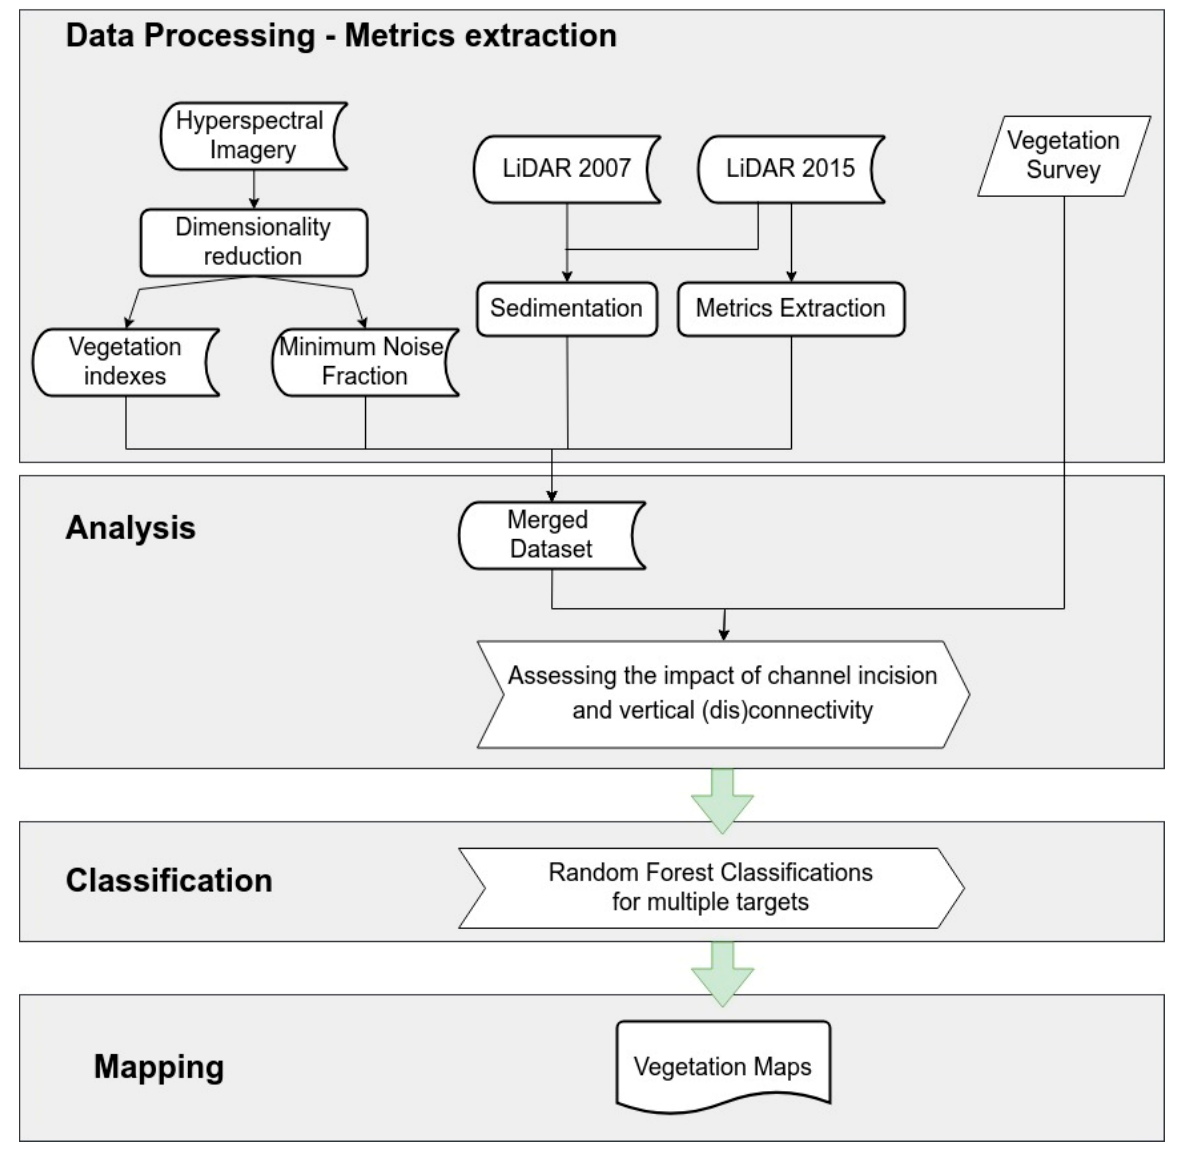
Figure 4. Overall methodology applied in this paper.